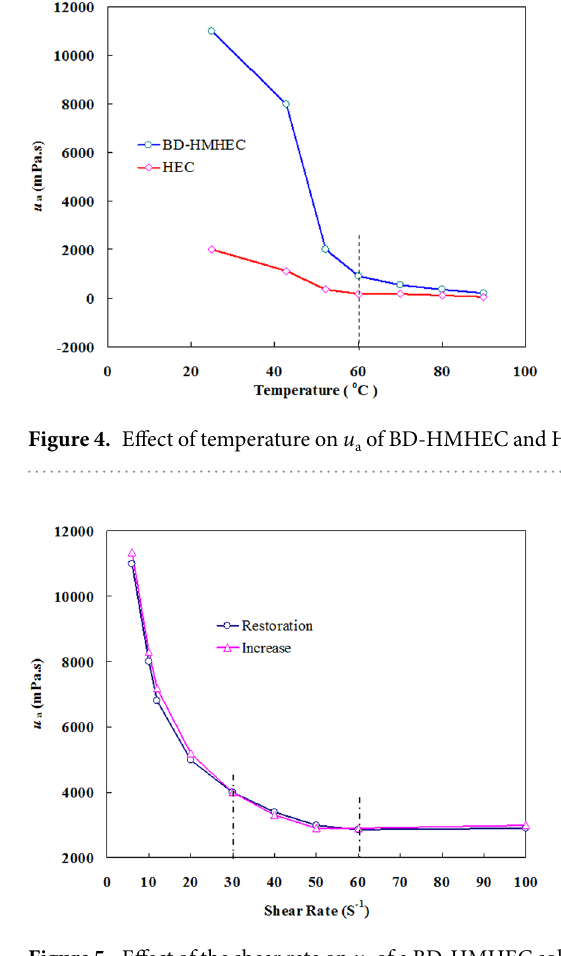
Figure 5. Effect of the shear rate on u a of a BD-HMHEC